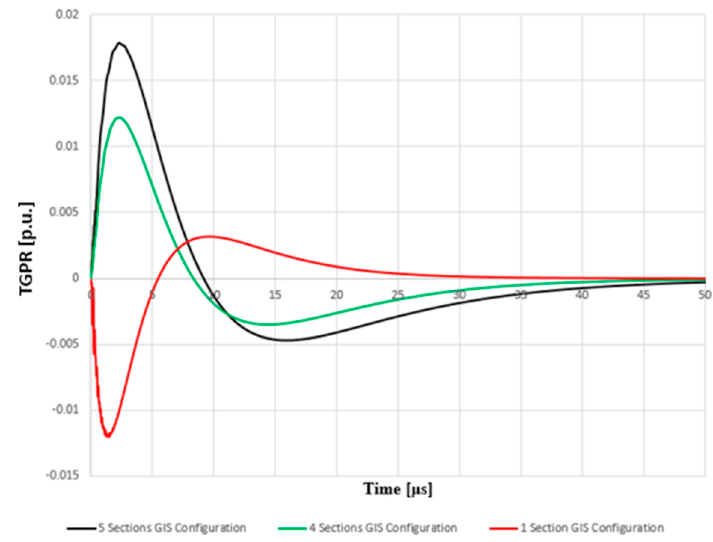
Figure 13. TGPR, one particular vertical rod, comparison considering several GIS configurations.